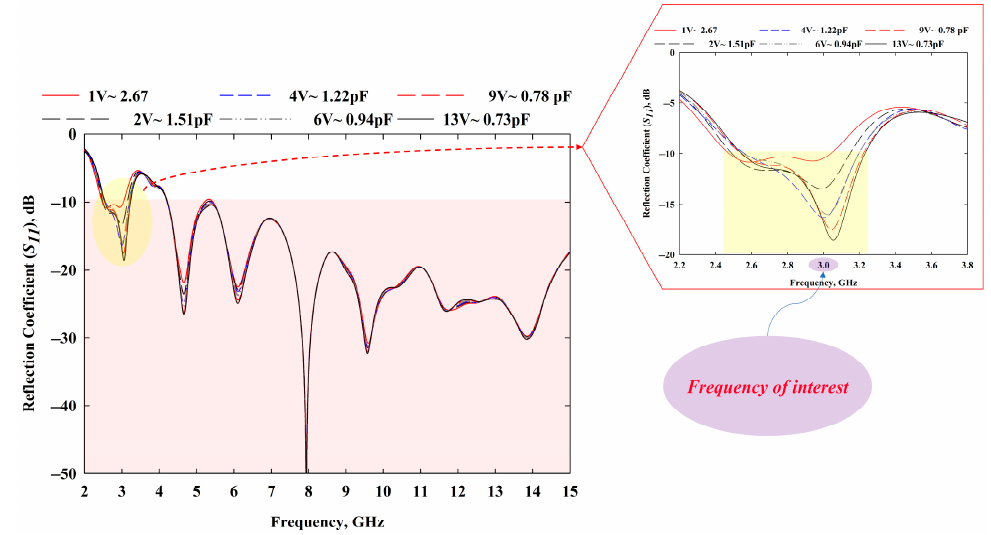
Figure 7. Simulated reflection coefficient, S 11 results.